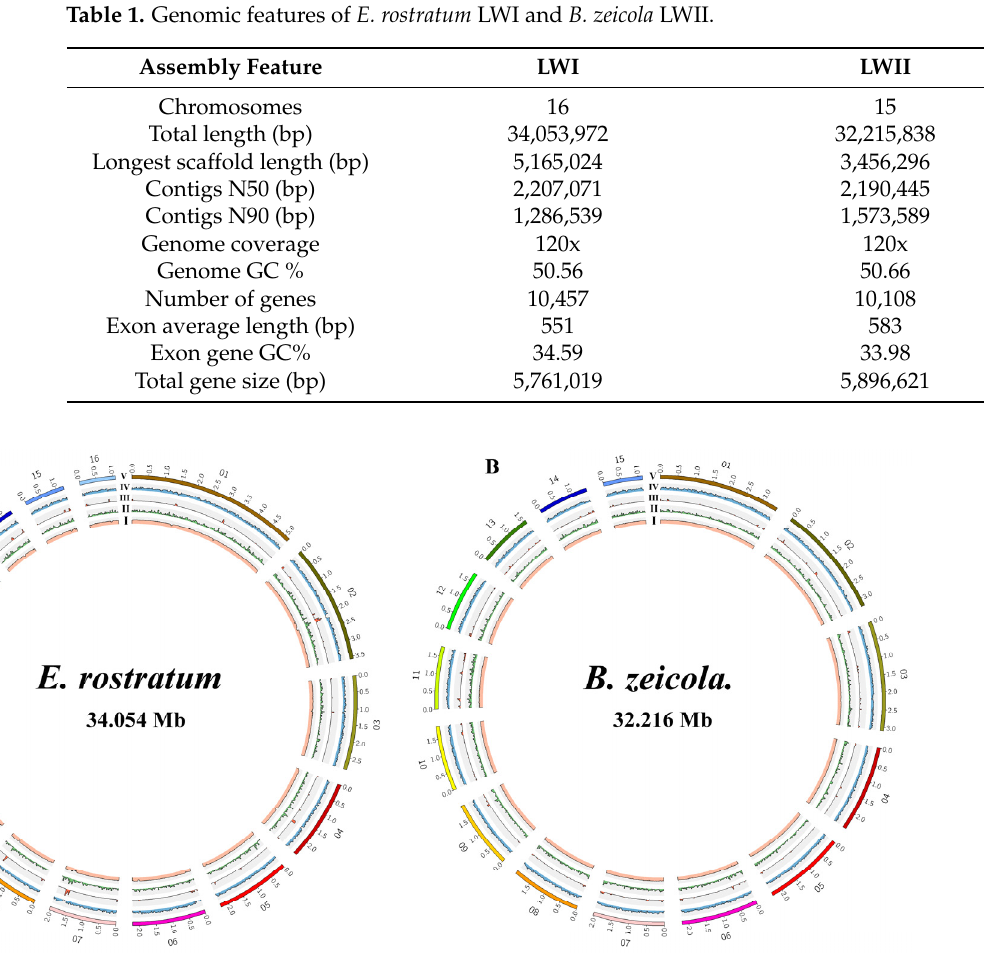
Figure 3. Genome visualization map of partial gene annotation results of E. rostratum LWI ( A ) and B. zeicola LWII ( B ). I : GC content. II : Repeat sequence analysis. III : Long terminal repeats (LTRs). IV : Gene density. V : Genomic fragment sizes of E. rostratum LWI ( A ) and B. zeicola LWII ( B ).